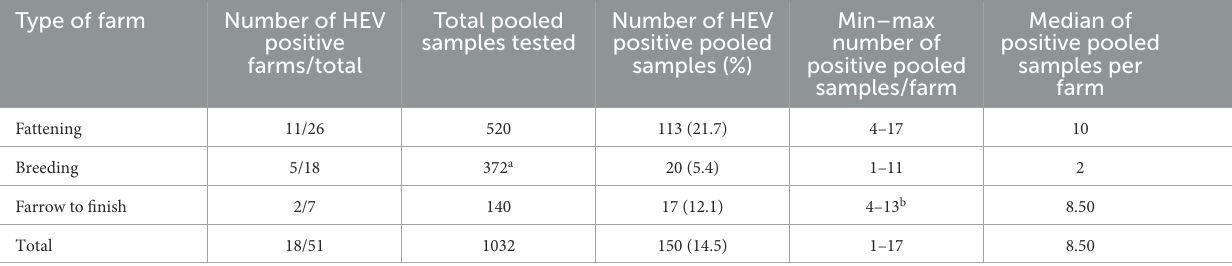
TABLE 2 Summary of results obtained for HEV-detection for each farm in the pooled samples of